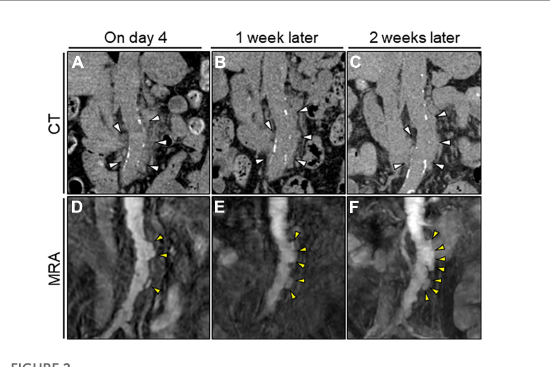
FIGURE2 Serial unenhanced CT and MRA assessment of the abdominal aorta. (A–C) Serial unenhanced reconstructed coronal CT image showing no significant change in the periaortic mass of the abdominal aorta (white arrowheads). (D) Initial TS-MIP image of the original MRA image showing several asymmetric aortic dilatations in the abdominal aorta (yellow arrowheads). (D–F) Serial TS-MIP of the original MRA image showing rapid aortic expansion with multilobular protrusion of the abdominal aorta to the left side (yellow arrowheads). CT, computed tomography; MRA, magnetic resonance angiography; TS-MIP, thin-slab maximum intensity